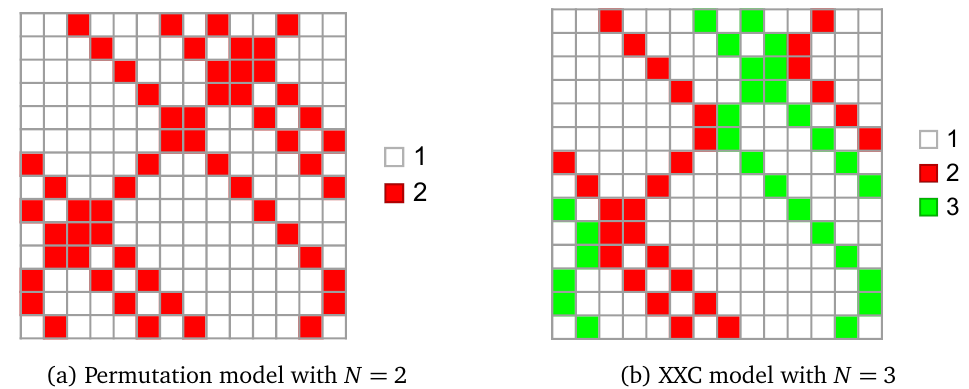
Figure 1: Examples for time evolution in the classical cellular automata. In the plots the vertical direction corresponds to time, and the horizontal to space; the initial condition is given by the uppermost row, and time flows downwards. We plotted V both half-steps of the Floquet cycle V = V , and we use a convention such that 2 1 the addition of two rows corresponds to t → t + 2. This way the speed of propaga- tion in the permutation model is v = ± 1. In the space direction periodic boundary conditions are